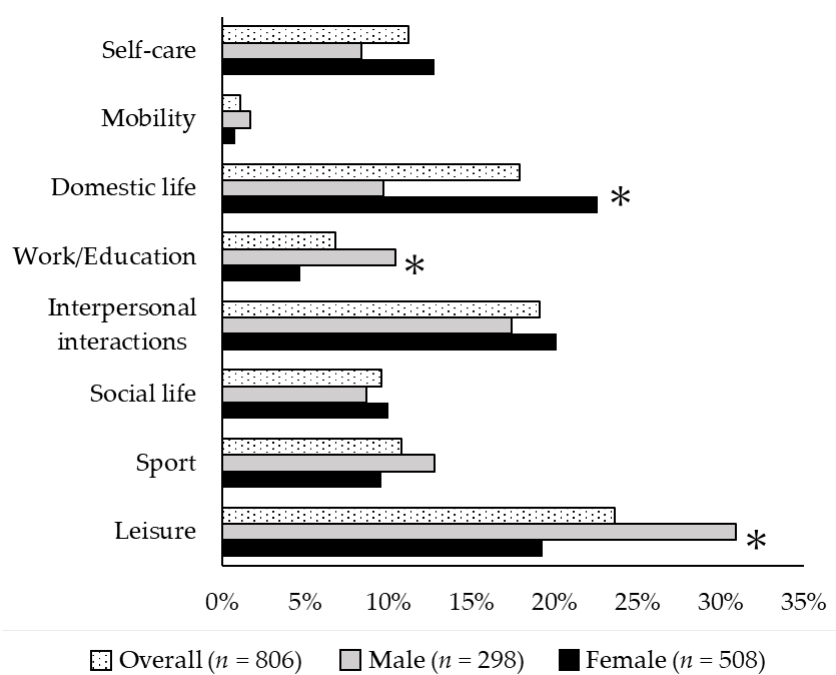
Figure 2. Comparison of activities participants found meaningful. The proportion of activity categories men and women consider to be meaningful is shown. Leisure (men: 30.9%, women: 19.3%; p < 0.01) and work / education (men: 10.4%, women: 4.7%; p < 0.01) were more frequently chosen by men, while domestic life (men: 9.7%, women: 22.6%; p < 0.01) was most frequently chosen by women. Other activities did not differ by gender.